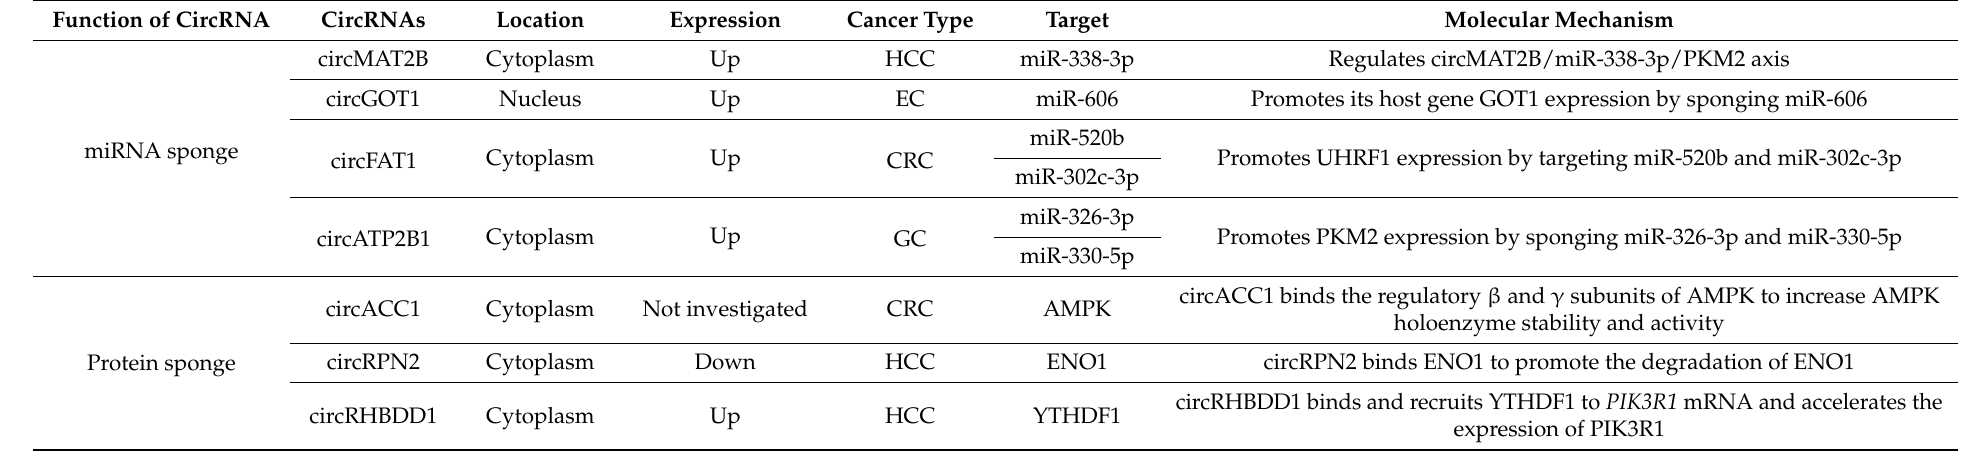
Table 2. The biological functions of glycolysis-associated circRNAs in GI